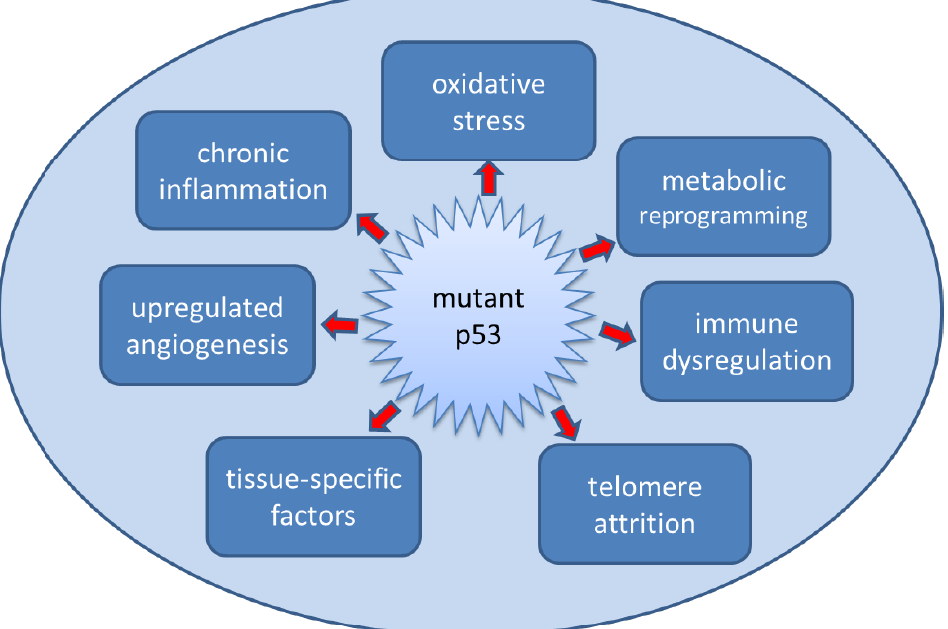
Figure 1. Mutated p53 function leads to the creation of a pre-cancerous niche. Mutant p53 drives the creation of specific biological niches in which chronic inflammatory responses, including elevated basal oxidative stress, metabolic reprogramming, the release of pro-angiogenic factors and immune dysregulation combine to create the conditions conducive to malignant transformation. Increased oxidative stress and/or telomere attrition and tissue-specific factors, for example increased aromatase expression in the breast, contribute to additional genetic events leading to cancer initiation that arises in these cancer-supporting niches.